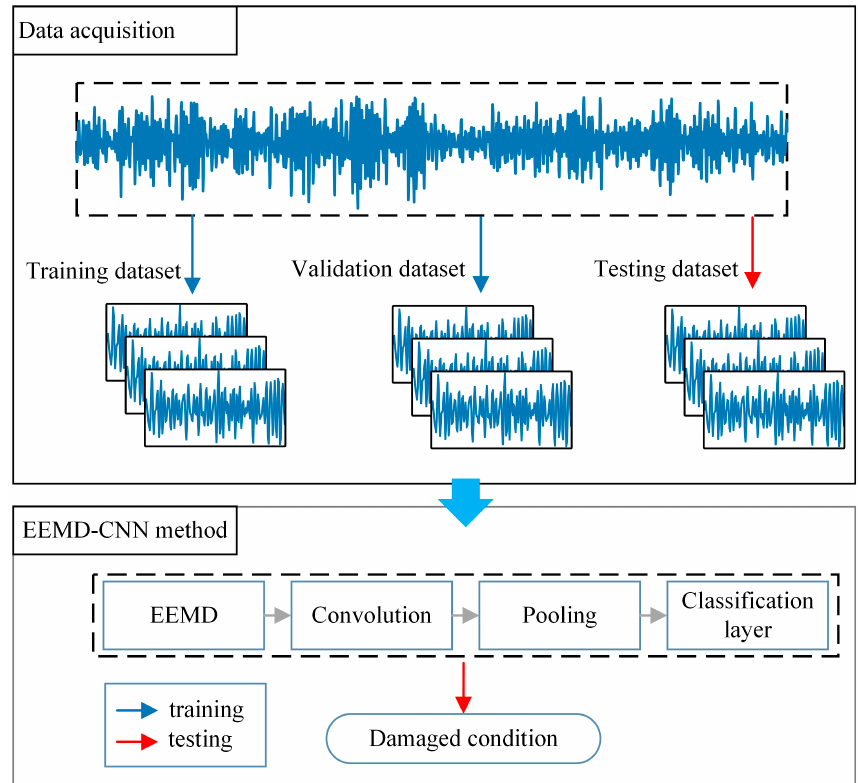
Figure 2. Flowchart of the proposed EEMD-PCC-CNN for structural damage identification.